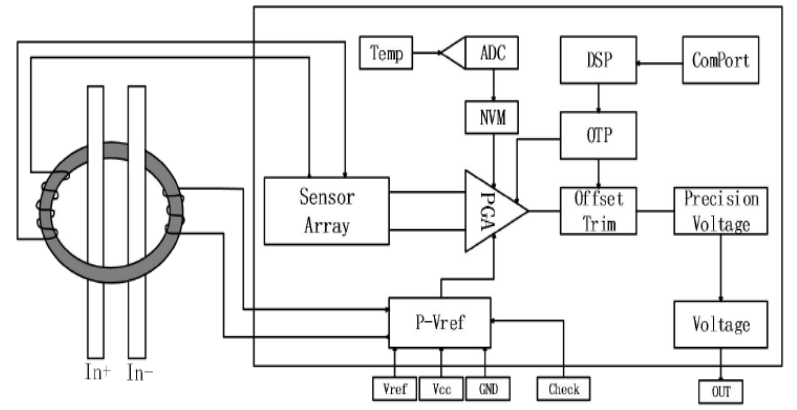
Figure 9. Magnetic flux gate current sensing chip function block diagram.